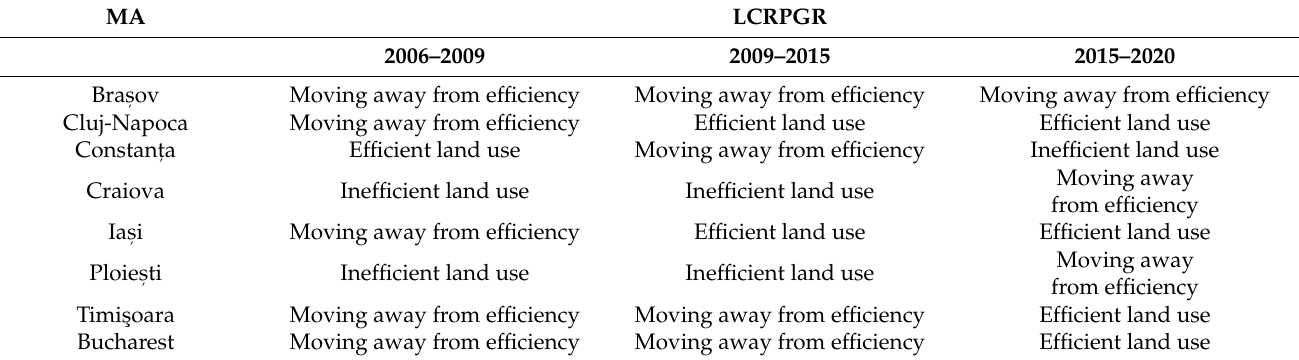
Table 6. Temporal variability of the LCRPGR classes at metropolitan area